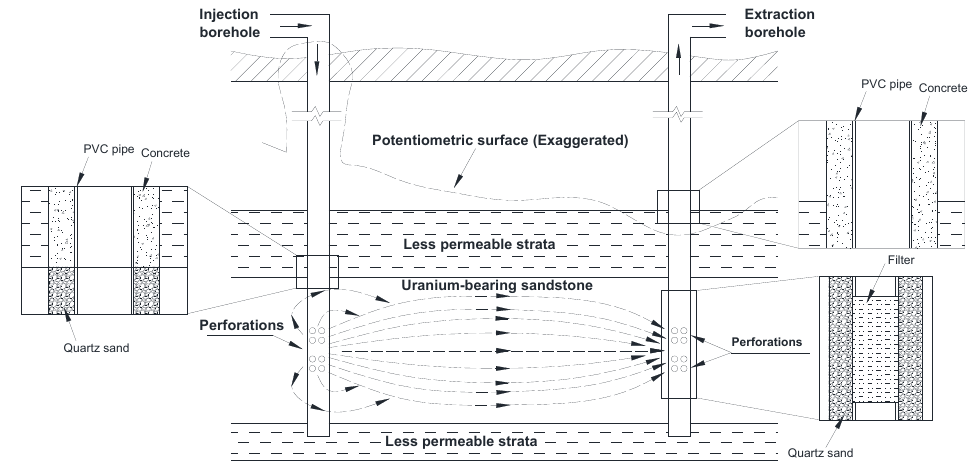
Figure 7. In situ leach technology for uranium exploitation and its influence on the groundwater level.